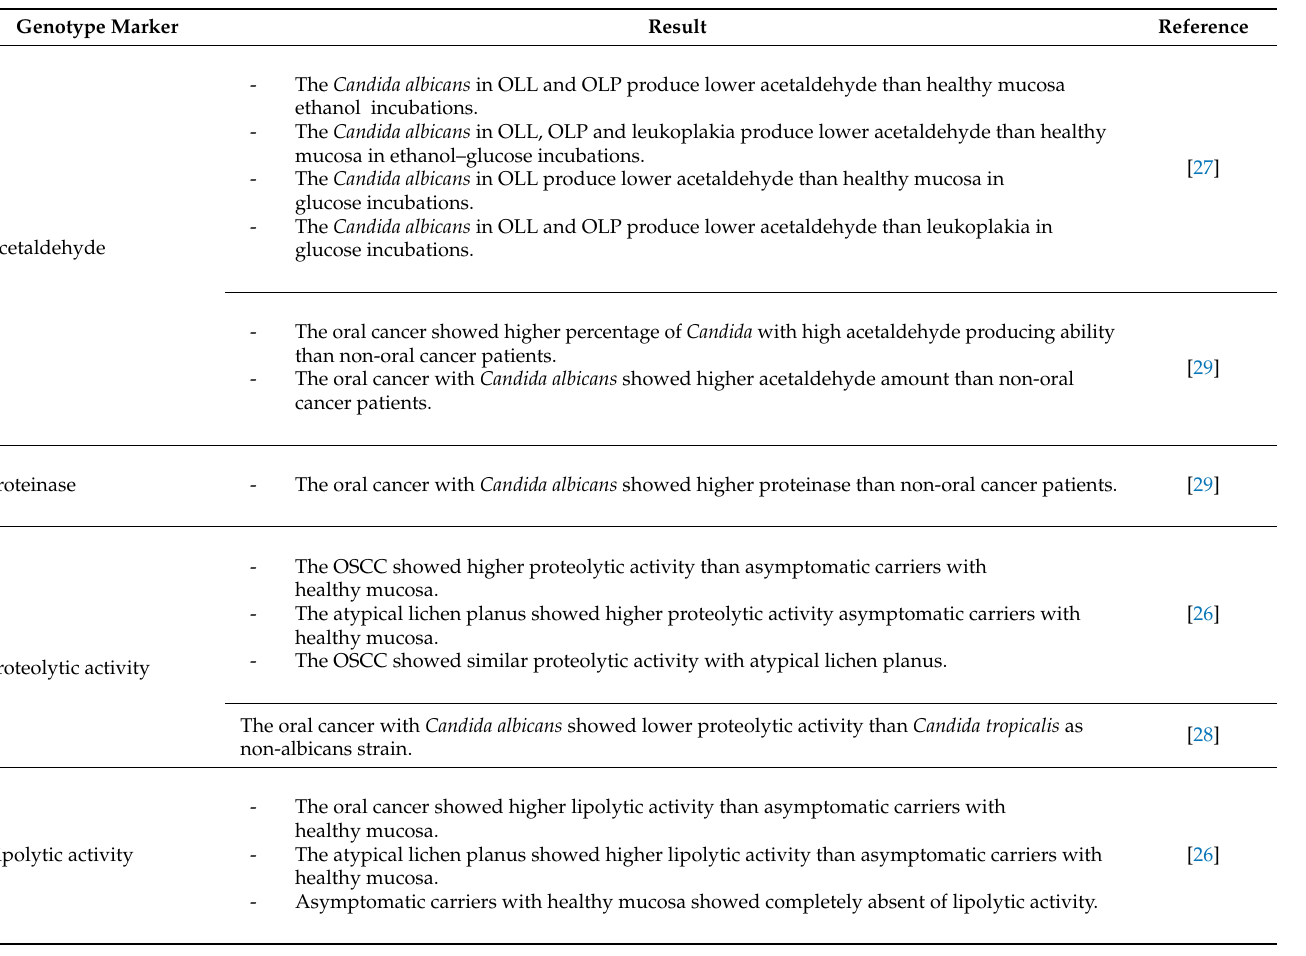
Table 5. The Candida albicans metabolic product identified in each